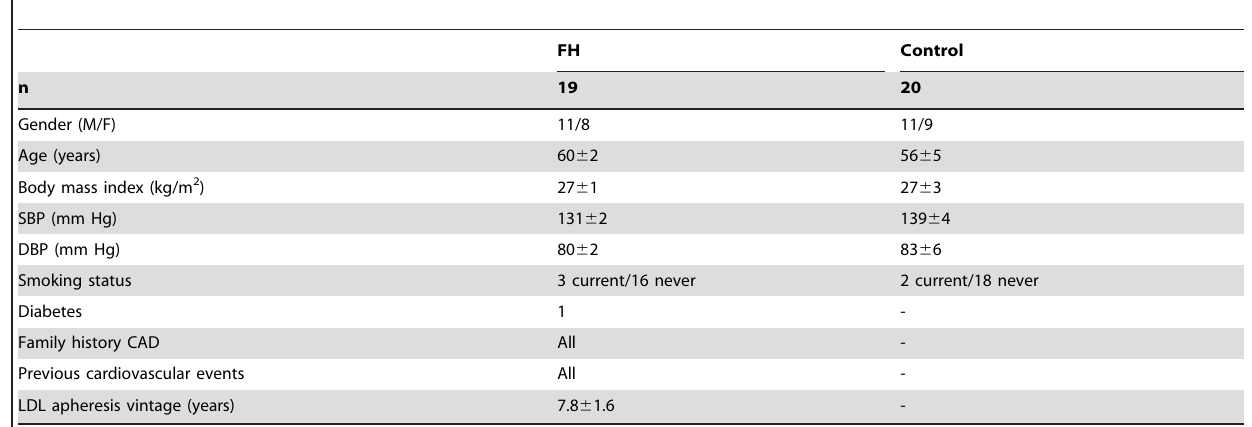
FH: familial hypercholesterolemia. Data are means 6 SEM. SBP: systolic blood pressure; DBP: diastolic arterial pressure; CAD: coronary artery disease. doi:10.1371/journal.pone.0101290.t001 PLOS ONE |